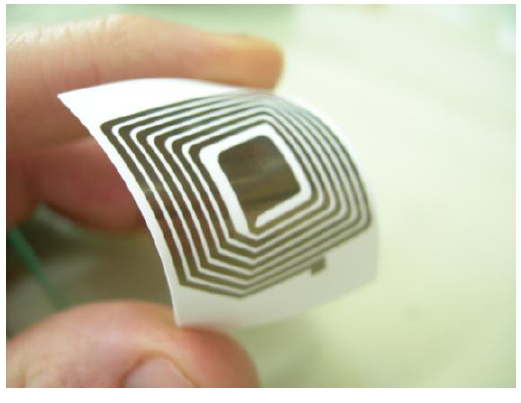
Figure 6. A flexible RFID antenna printed using copper-silver core-shell ink on inkjet photo